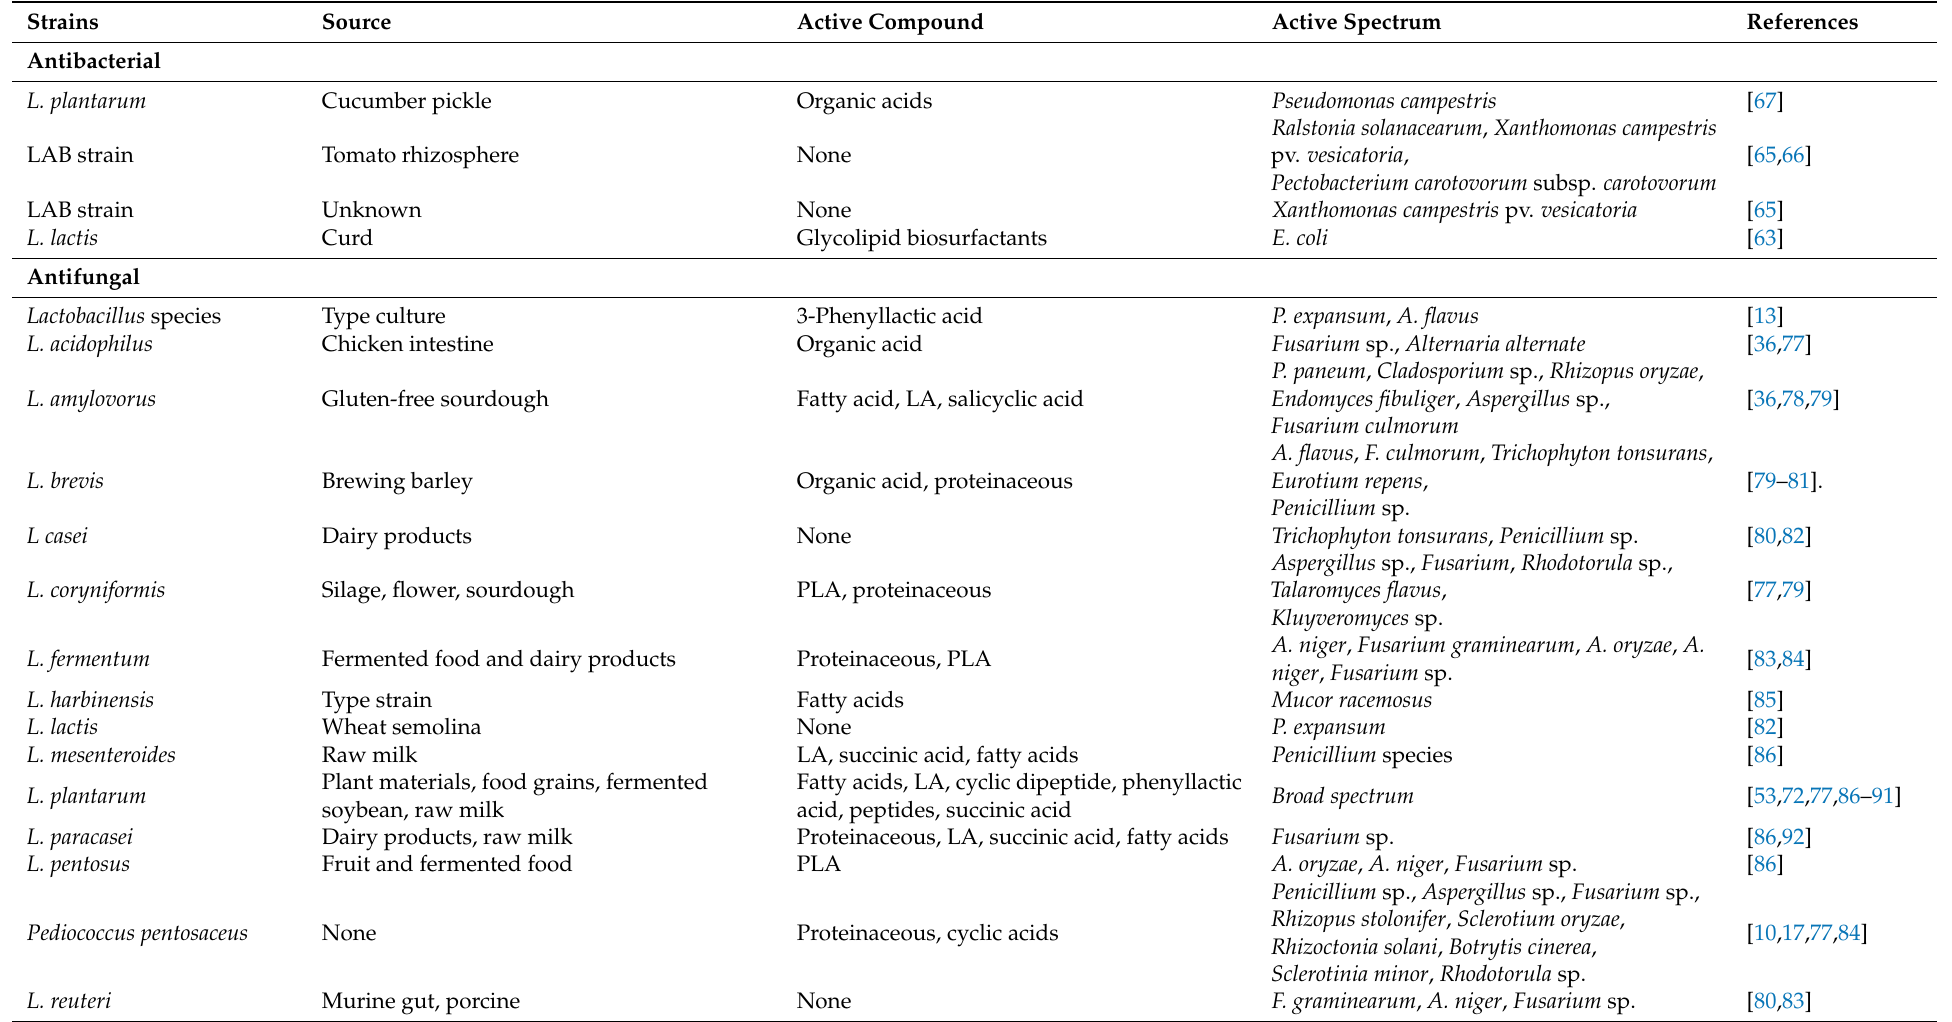
Table 2. Lactic acid bacteria and their active compounds against plant pathogenic